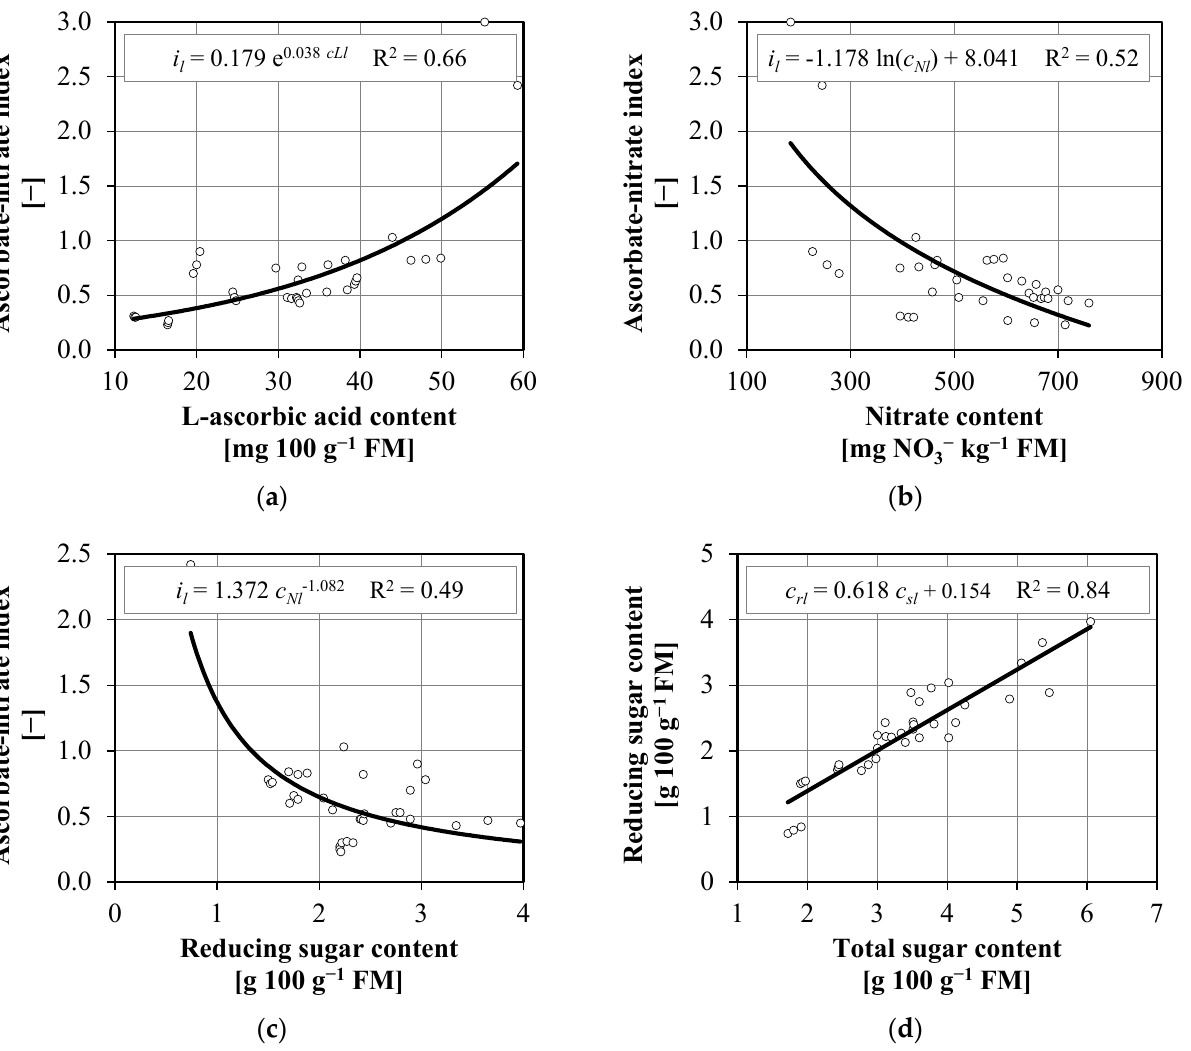
Figure 7. Correlations between the chemical composition parameters of shallot leaves: ( a ) L-ascorbic acid content and ascorbate-nitrate index, ( b ) nitrate content and ascorbate-nitrate index, ( c ) reducing sugar content and ascorbate-nitrate index, ( d ) total sugar content and reducing sugar content. The correlations between the chemical composition parameters of shallot bulbs and leaves are presented in Figure 8. An increase in the dry matter content of bulbs (by approx.